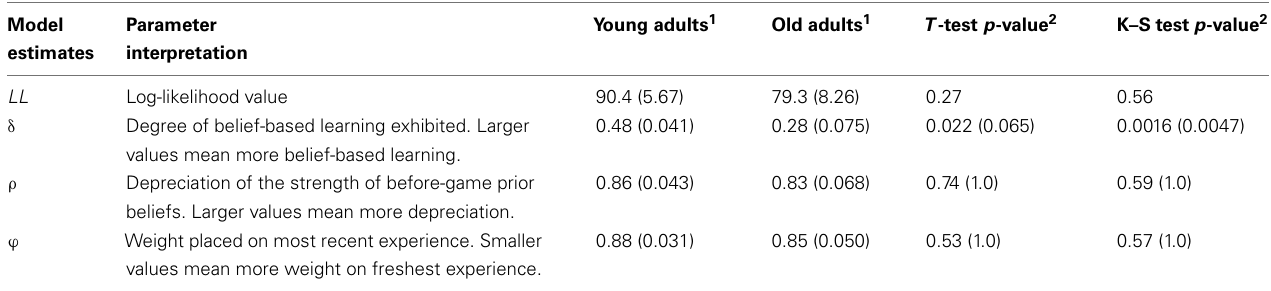
Table 3 | EWA parameters and their interpretations, as well as parameter estimates from young and old cohorts.